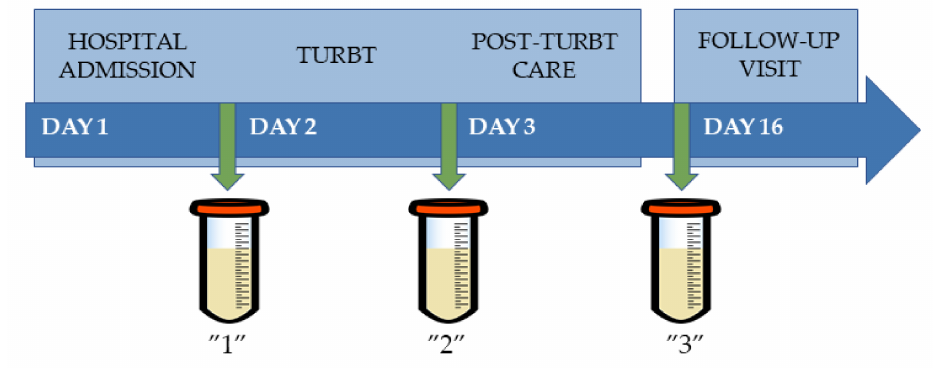
Figure 1. Scheme illustrating sample collection process. Legend: “1” (first time point, first morning urine samples collected on the day of TURBT, before the procedure), “2” (second time point, first morning urine samples collected the day after TURBT), “3” (third time point, first morning urine samples collected 14 days after